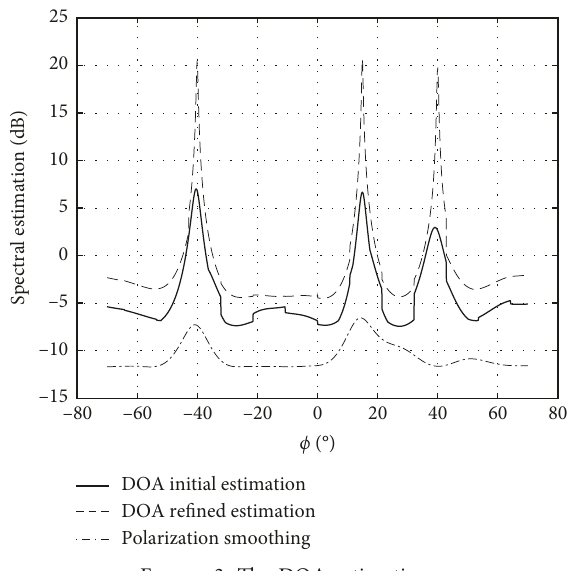
Figure 3: The DOA estimation.